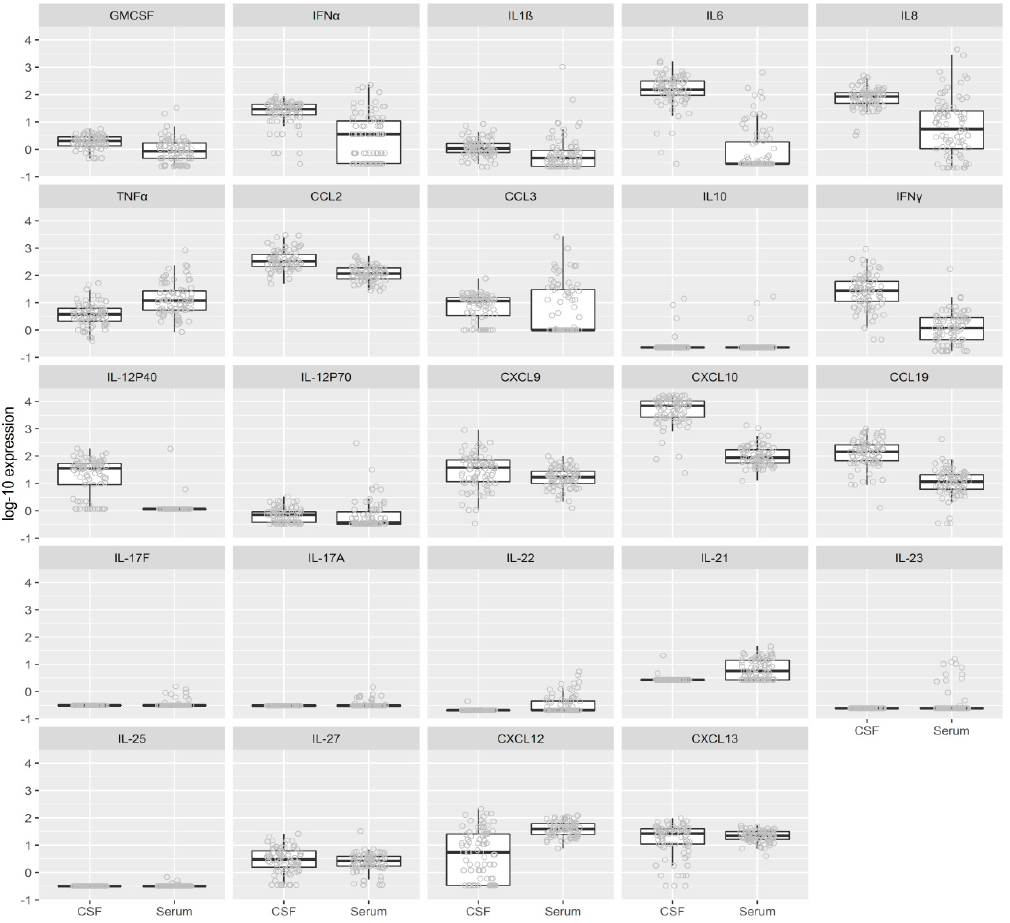
Figure 2. Levels of 24 Cytokines and Chemokines Associated with Innate or Adaptive Immune Responses Assessed in Matched Serum and Cerebrospinal Fluid (CSF) Samples Obtained on the Same Day during Meningoencephalitic Phase of